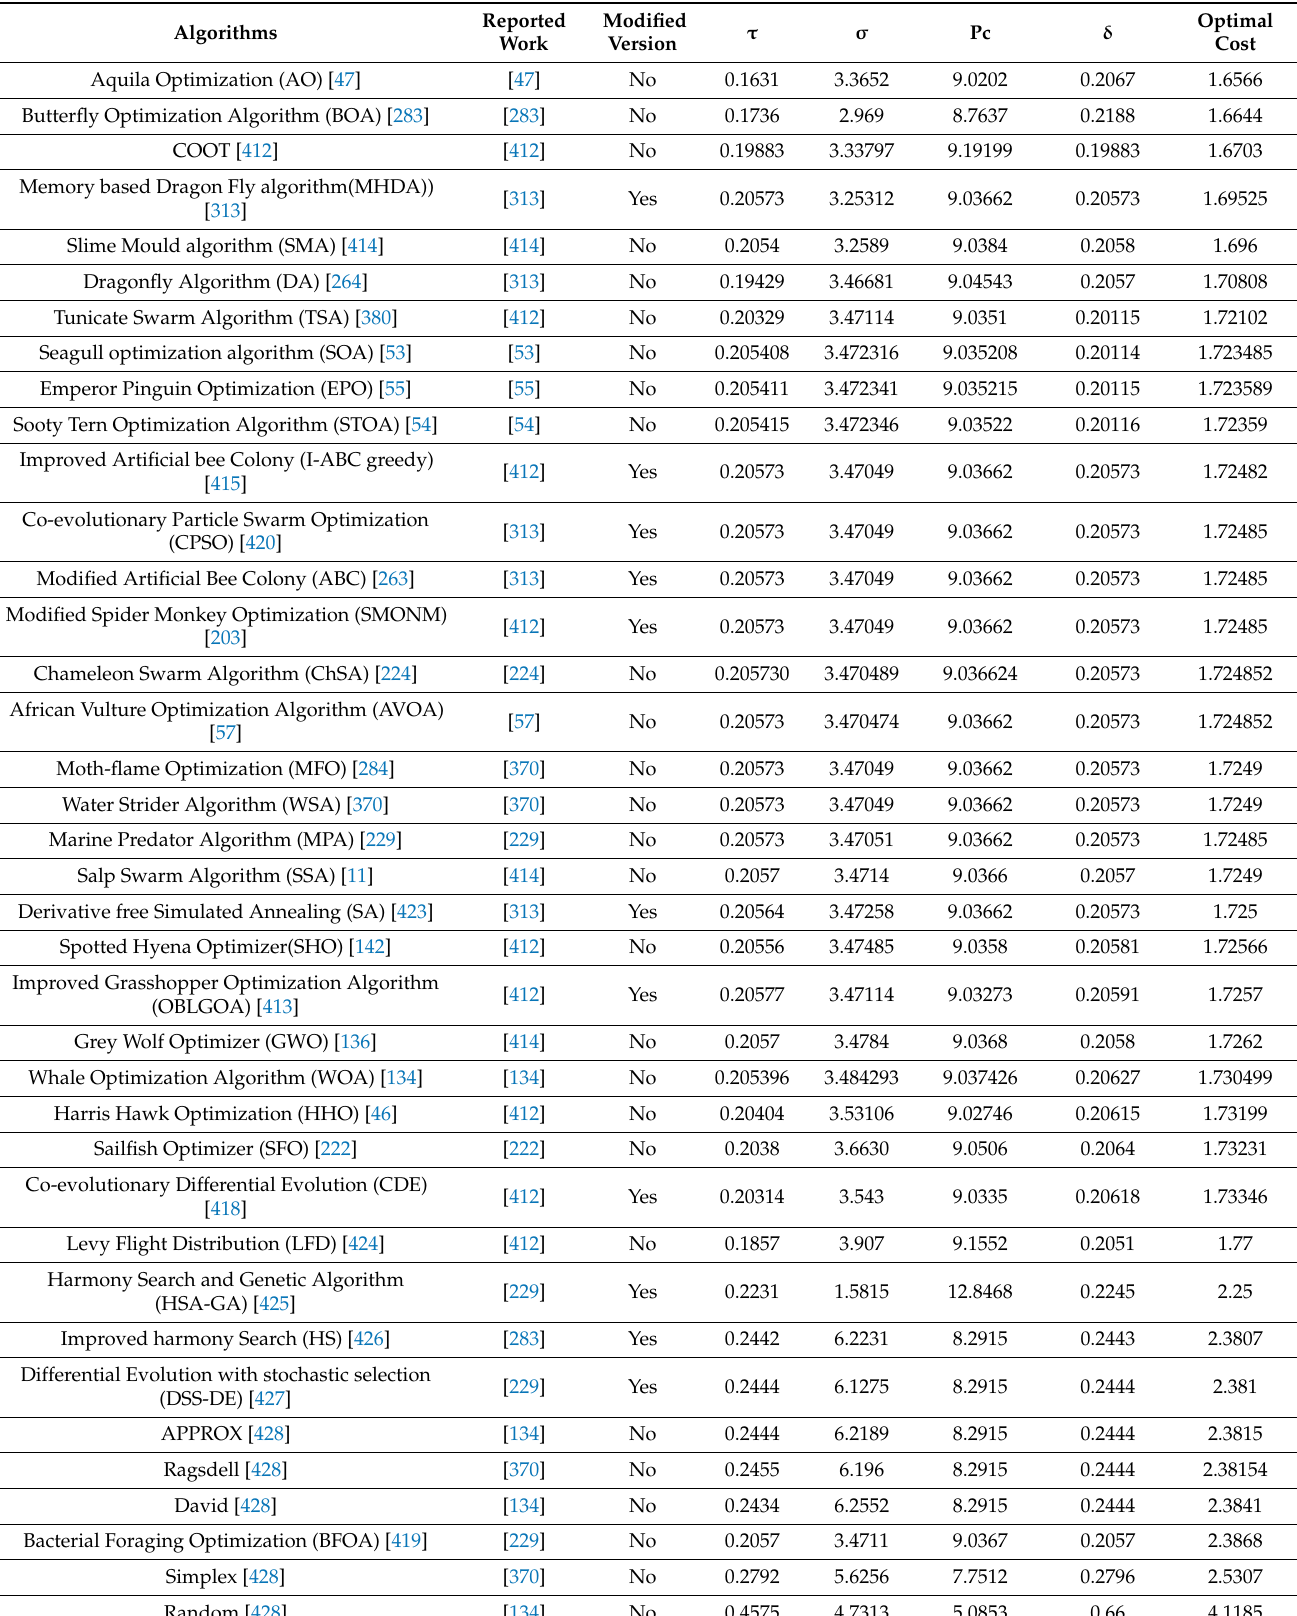
Table 9. Solutions for the welded beam